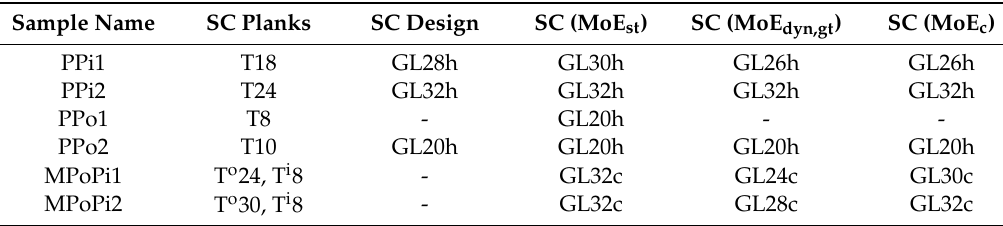
Table 2. Strength grading for the tested samples according to the di ff erent modulus of elasticity. MoE st : static modulus of elasticity. MoE dyn,gt : dynamic modulus of elasticity. MoE c : semi-anaytical